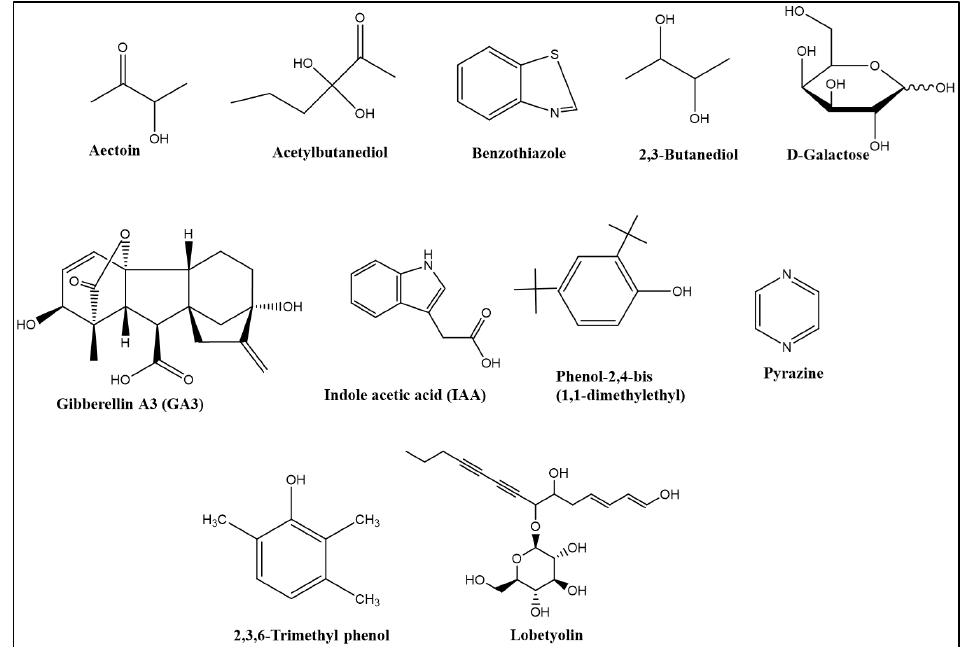
Figure 2. The structure of beneficial compounds other than LP- and PK-type addressed in this article. VOCs: benzothiazoles phenol; 2,3,6-trimethyl phenol; pyrazine (2,5-dimethyl); benzothia- zole (4-chloro-3-methyl); phenol-2,4-bis (1,1-dimethylethyl); ISR induction: 2,3-butanediol; growth promotion: IAA and GA3; pharmaceutical compound: